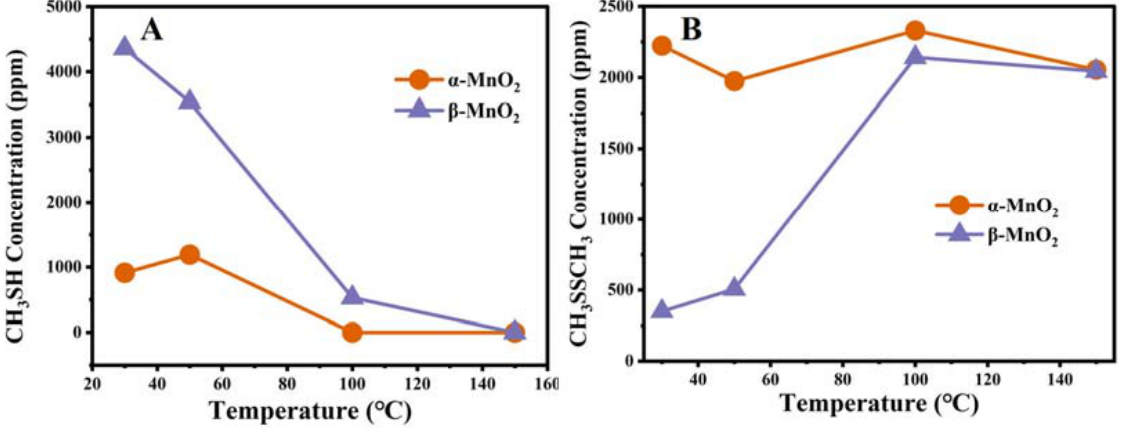
Figure 12. The CH 3 SH ( A ) and CH 3 SSCH 3 ( B ) concentration on α -MnO 2 and β -MnO 2 .